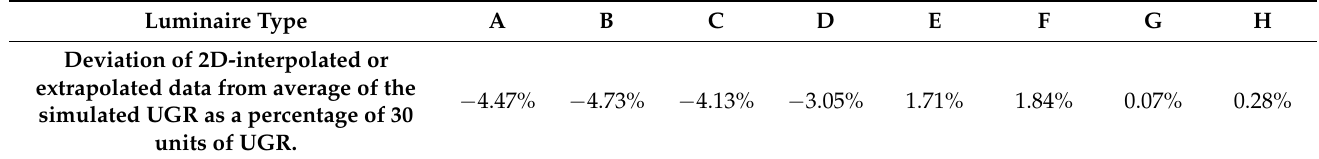
Table 5. The deviation of 2D-interpolated or extrapolated UGR average from the simulated UGR average for luminaires A to H.